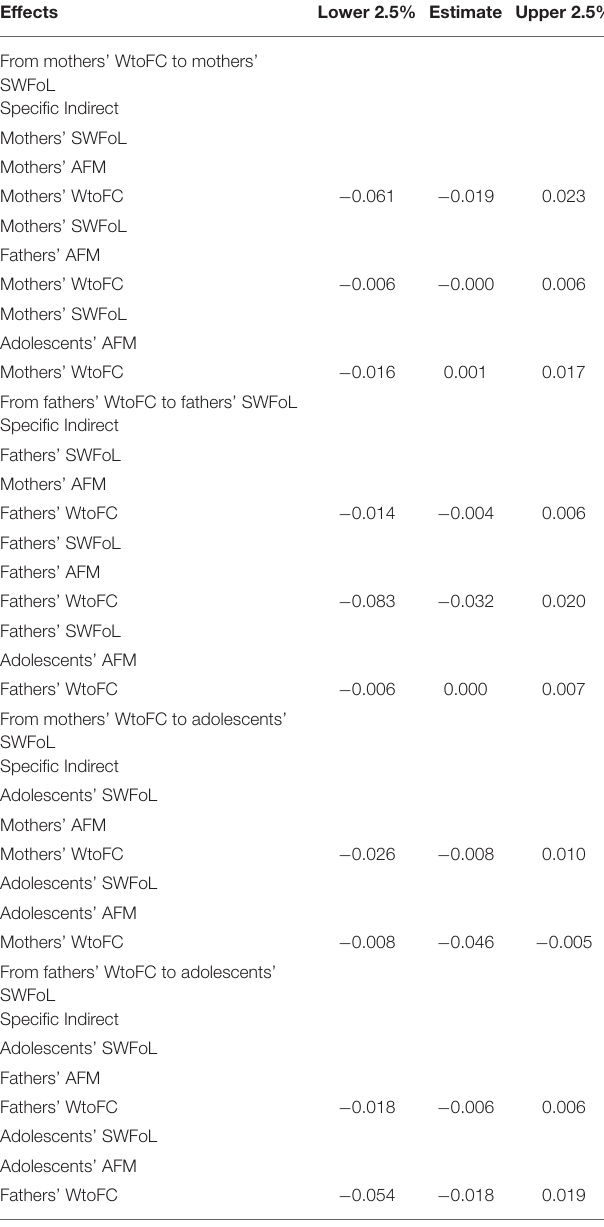
TABLE 4 | Bias-corrected confidence intervals of specific mediation effects of the three family members’ perception of the atmosphere of family meals (AFM).